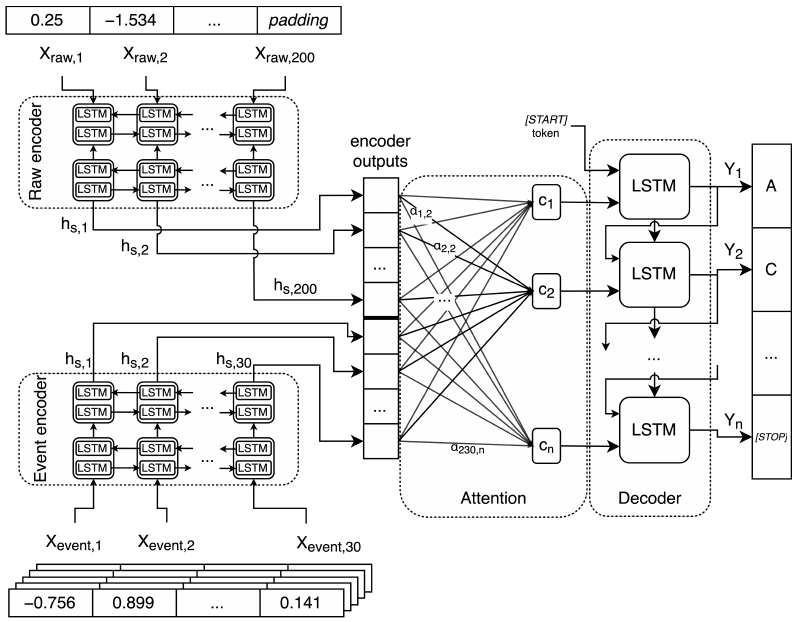
Figure 6. Detailed block diagram of Ravvent basecaller. It processes raw and event data with indi- vidual encoders using two BiLSTM layers. Their outputs are then subjected to attention mechanism. The produced context vectors c are then used by single LSTM layer decoder which generates the final base